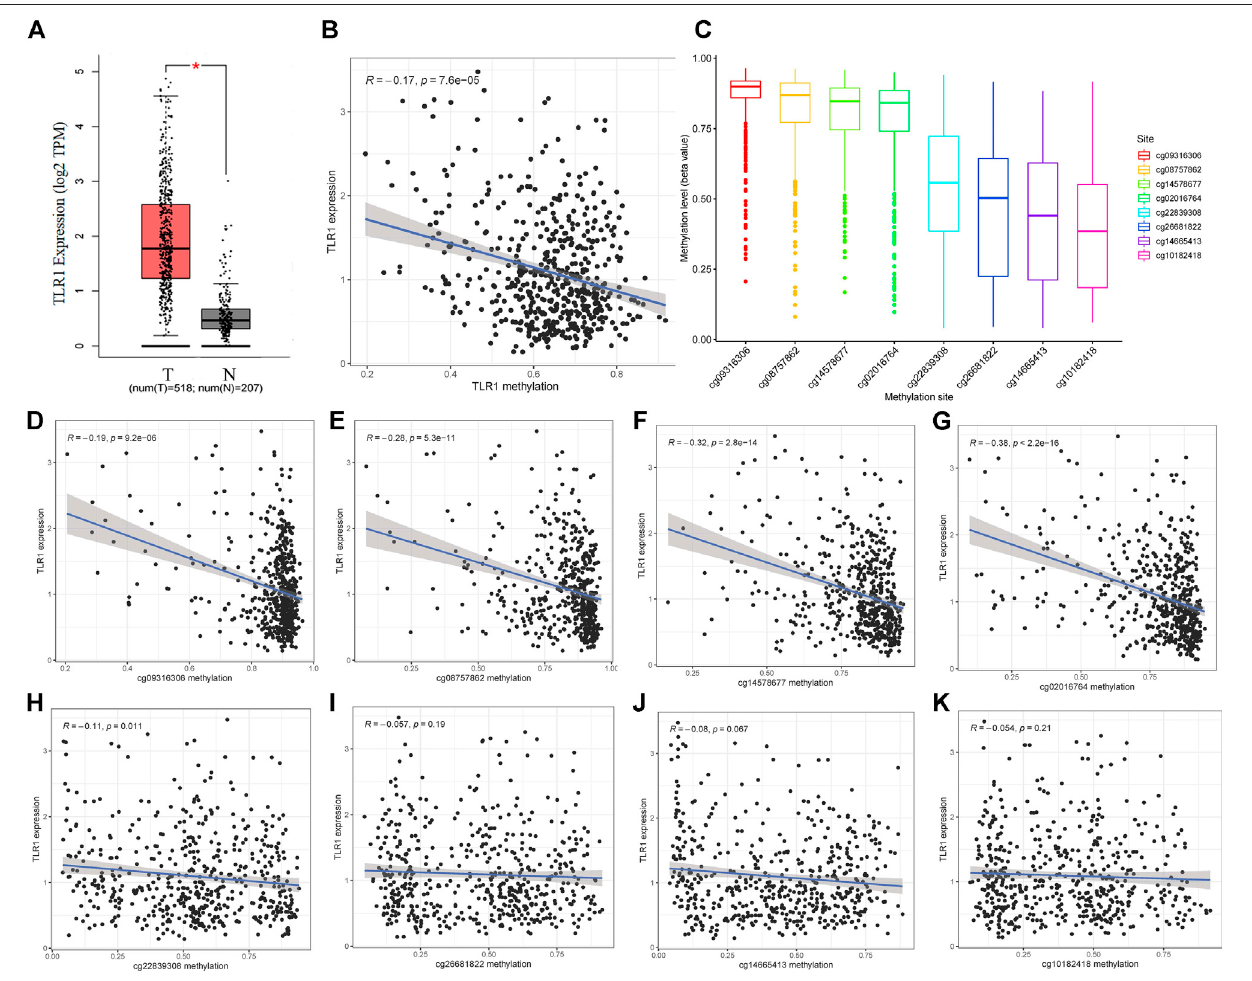
FIGURE3| TheexpressionandmethylationofTLR1inLGGtissuesandnormaltissuesrevealedbybioinformaticanalysis. (A) TLR1mRNAisstronglyexpressedin LGG tissues inTCGAdataset. (B) Theexpression ofTLR1 wasnegativelyregulatedbyDNAmethylation. (C) Thedistributionof8TLR1DNApromoterCpGsites. (D – K) Correlation analysis ofTLR1 CpG sites and TLR1 mRNA expression.